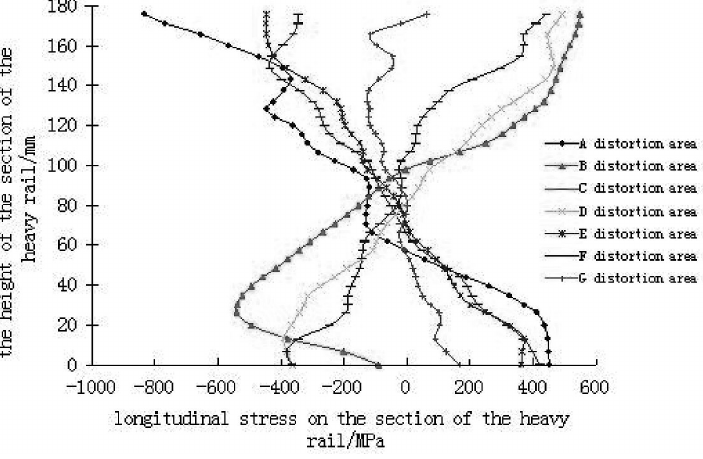
Fig. 6. The stress changing of rail section’s symmetry line during H-straightening.